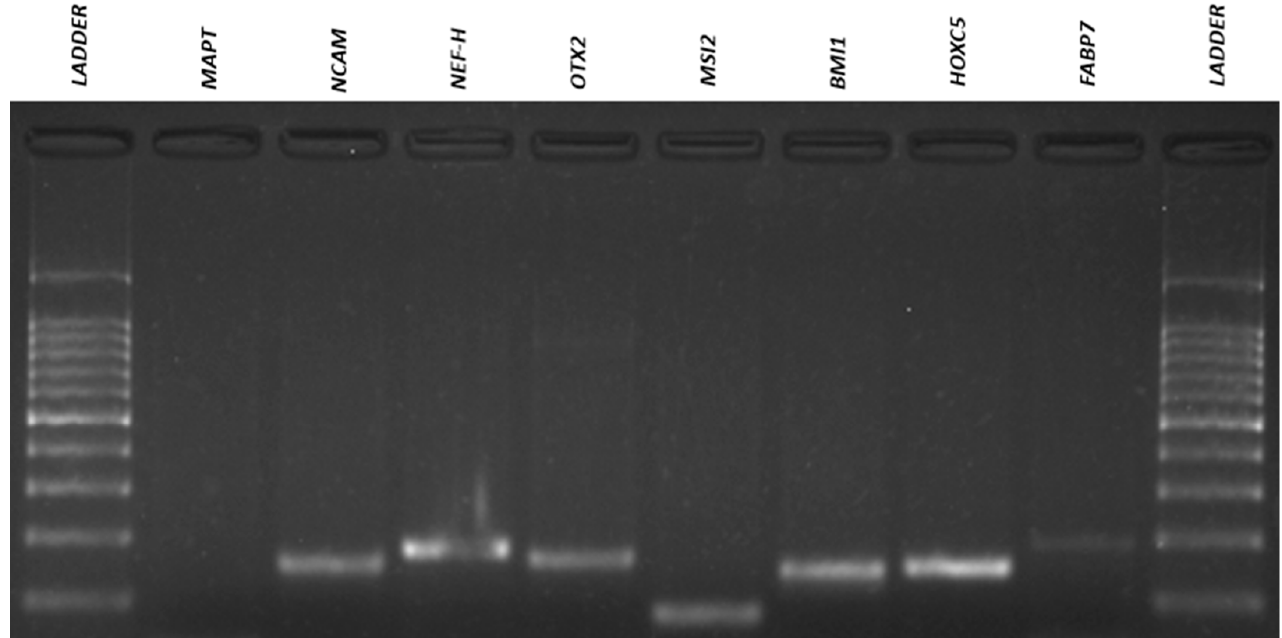
Figure 8. NPs electrophoresis gel. RT-PCR for amplification of OCT4 (292 bp), NANOG (578 bp), ACTB (564 bp), FGF2 (482 bp), REX1 (344 bp), VEGF (107 bp), ABCG2 (270 bp), TUBB3 (385 bp), GFAP (789bp), MAP2 (241bp), NEFM (98bp), SOX2 (224bp), NES (220bp), SLC1A3 (136bp), S100 (261bp) and ASCL1 (122bp) genes in NPs. NPs, neural precursors.